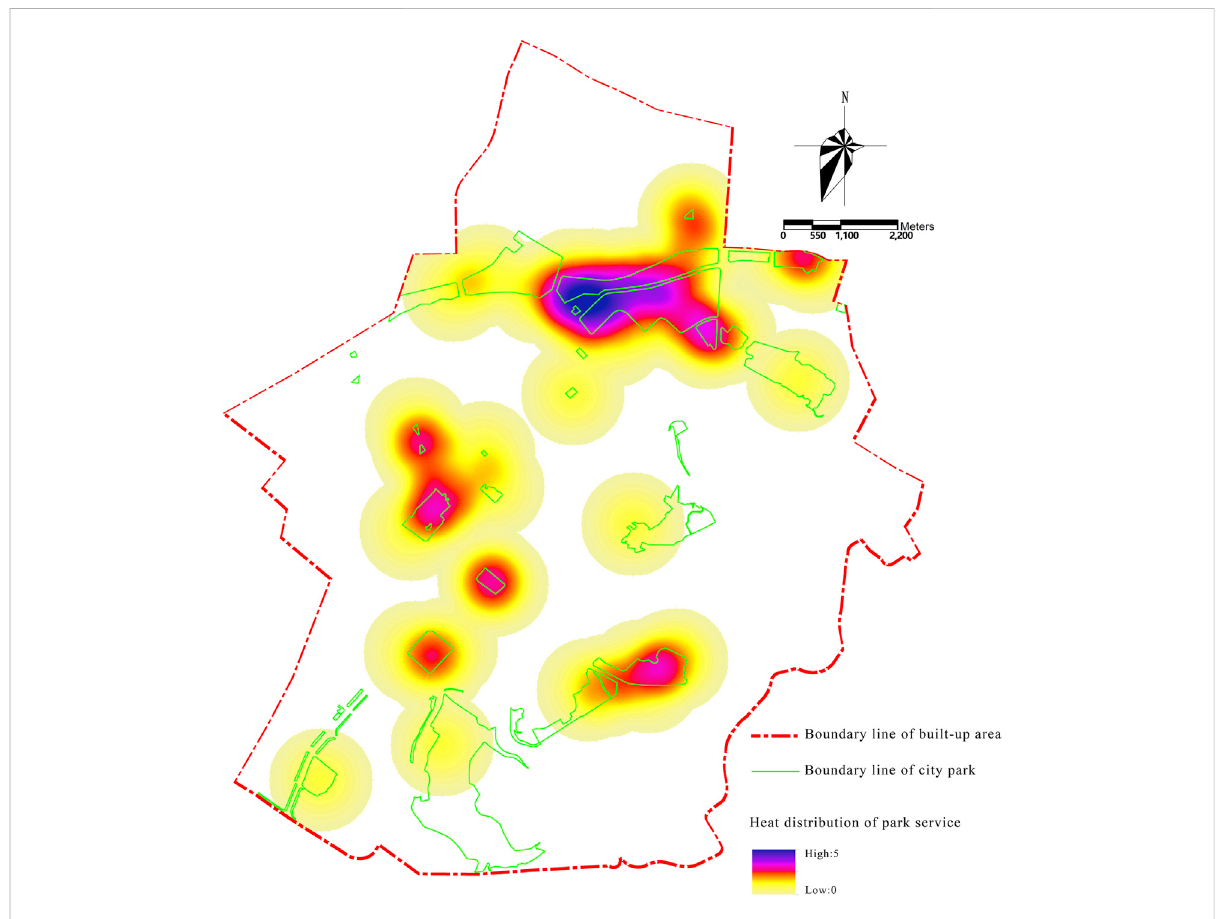
FIGURE 5 Distribution of park service pressure in Yuxi City